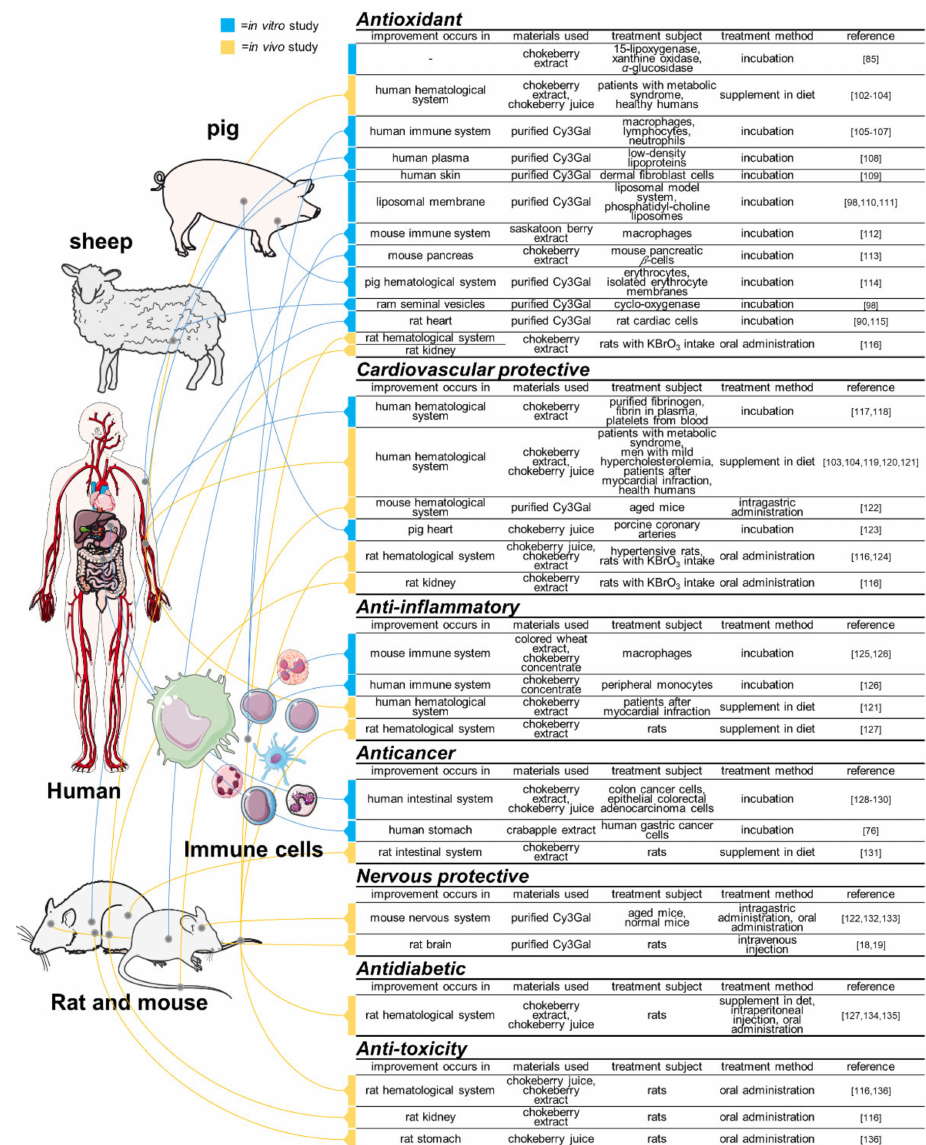
Figure 4. Studies in the physiological functions of cyanidin 3- O -galactoside and its enriched plant products. Blue color indicates the in vitro studies; orange indicates the in vivo studies. Precise induced physiological changes in the studied subjects of each studies are discussed in the